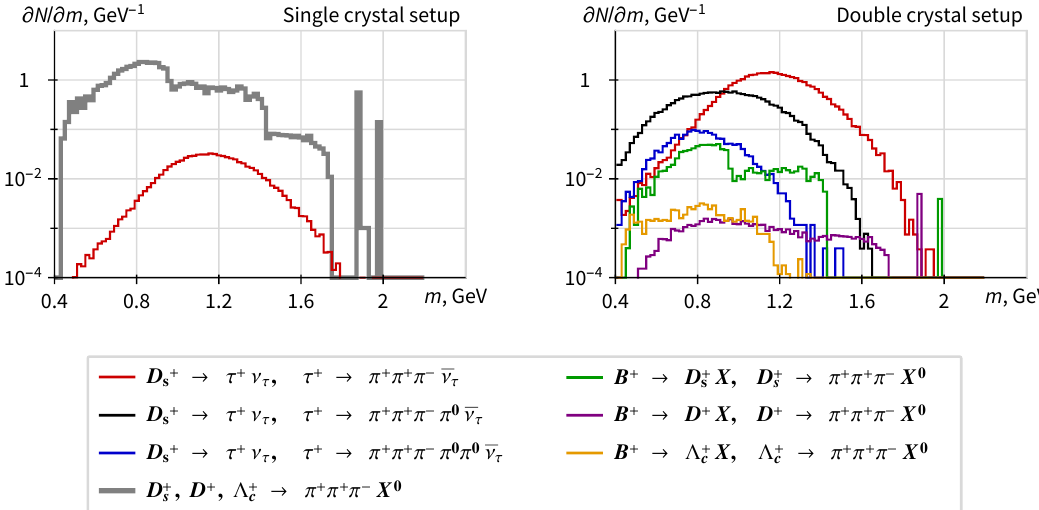
Figure 9 . Invariant mass distribution of (cid:25) + (cid:25) + (cid:25) (cid:0) combinations from (red line) the main decay (cid:28) + (cid:23) (cid:28) ; (cid:28) + (cid:25) + (cid:25) + (cid:25) (cid:0) (cid:23) (cid:28) , and for the background decay chains with (cid:25) + (cid:25) + (cid:25) (cid:0) in the chain, D + s ! ! (cid:12)nal state and listed at the bottom, using (left) a single-crystal setup and (right) a double-crystal